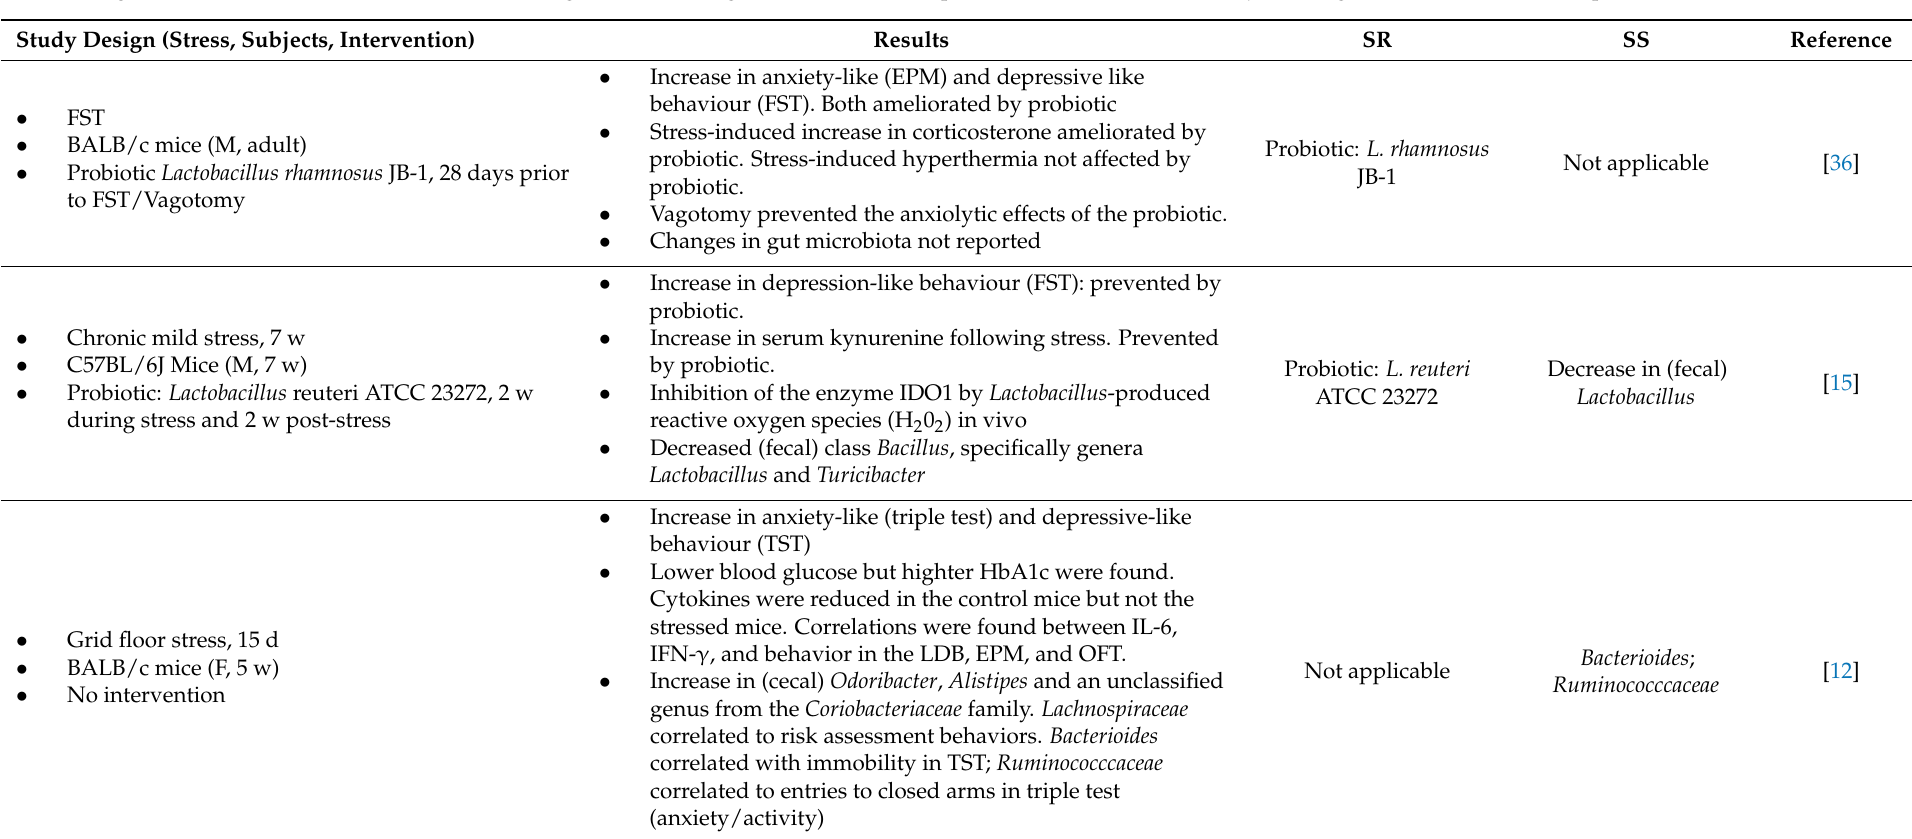
Table 2. Summary of studies investigating links between stress and the gut microbiota. Microbiota which show an association (not necessarily causality) with stress-resilience and stress-sensitivity are indicated in the columns labeled SR and SS, respectively. This depends on the study but may mean, e.g., a probiotic supplement which increased stress-resilience, or an increase in relative abundance of the microbiota in stress-resilient individuals. Abbreviations: EPM, Elevated Plus Maze; FST, Forced Swim Test; TST, Tail Suspension Test; HbA1c, Hemoglobin A1c; IL, Interleukin; IFN- γ , Interferon gamma; LDB, Light-Dark Box; OFT, Open Field Test; NOR, Novel Object Recognition; MSS, Maternal Separation Stress. Study Design (Stress, Subjects,